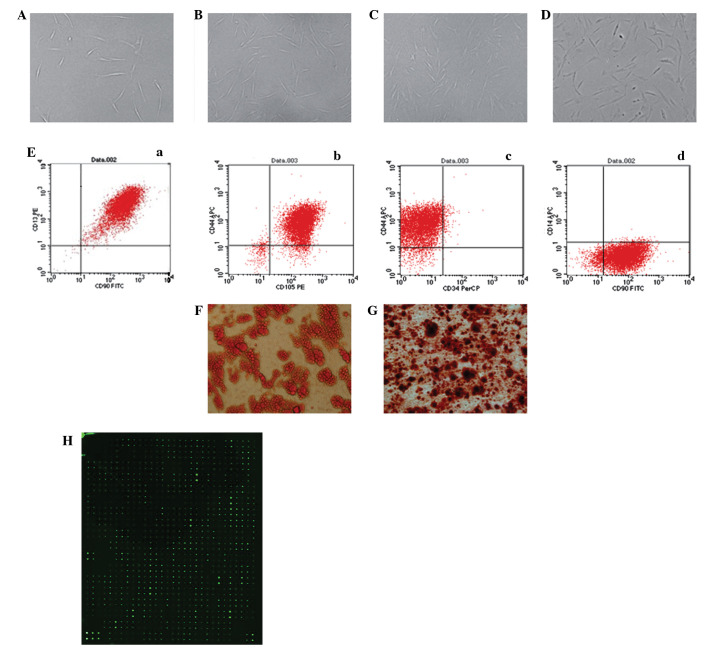
Isolation and culture of human adipose-derived stem cells (hASCs) in vitro [(A) P0 (B) P1 (C) P2 (D) P3, ×100 magnification]. (Ea-d) Flow cytometry performed on the hASCs in the 3rd passage showed that isolated hASCs positively expressed CD13, CD44, CD90, CD105 and negatively expressed CD14, CD34. (F) Adipogenic differentiated ASCs were positively stained by Oil Red O. (G) Osteogenic differentiated adipose-derived stem cells (ASCs) were positively stained by Alizarin red. (H) Protein microarray analysis of ASC-CM. ASC-CM, ASC-conditioned medium. P0, primary ASCs; P1, passage 1; P2, passage 2; P3, passage 3.